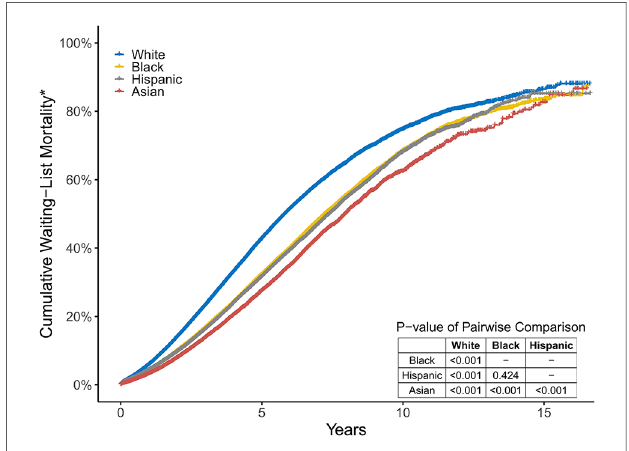
FIGURE 3 The cumulative percentage of those who died or became too sick for a transplant in the four groups. These two endpoints are simply referred to as Wait-List